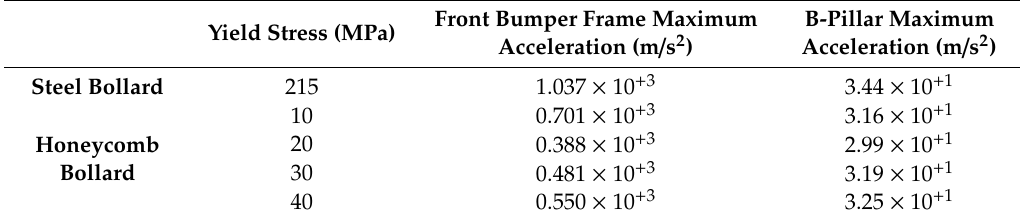
Table 2. Maximum accelerations of the front bumper and the B-pillar for the simulated vehicle-bollard collisions.